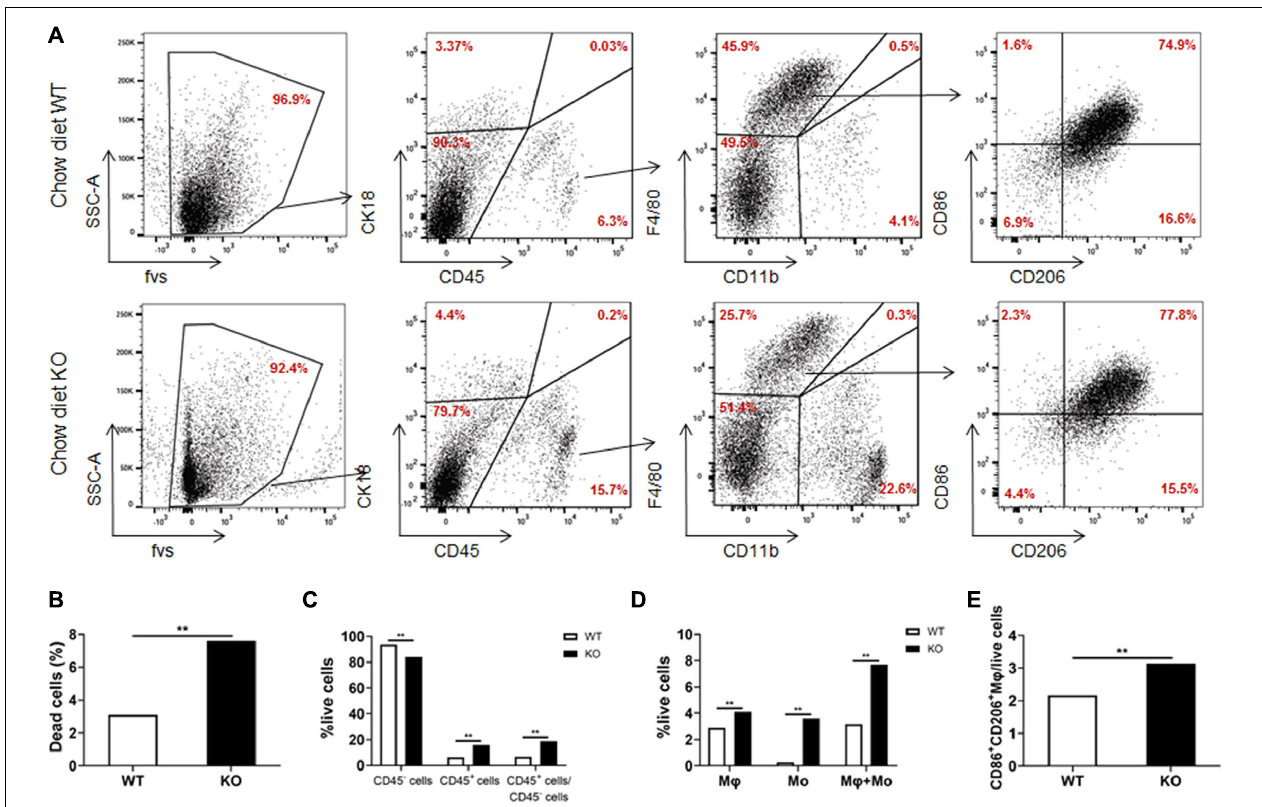
FIGURE 5 | Increased apoptosis and aggregation of immune cells in the liver of LAMTOR1 MKO mice. (A) Flow cytometry results (presented with same cell amount). (B) Percentage of dead cells. (C) Percentage of CD45 - cells, CD45 + cells, and the ratio of CD45 + /CD45 - cells within live cells. (D) Percentage of